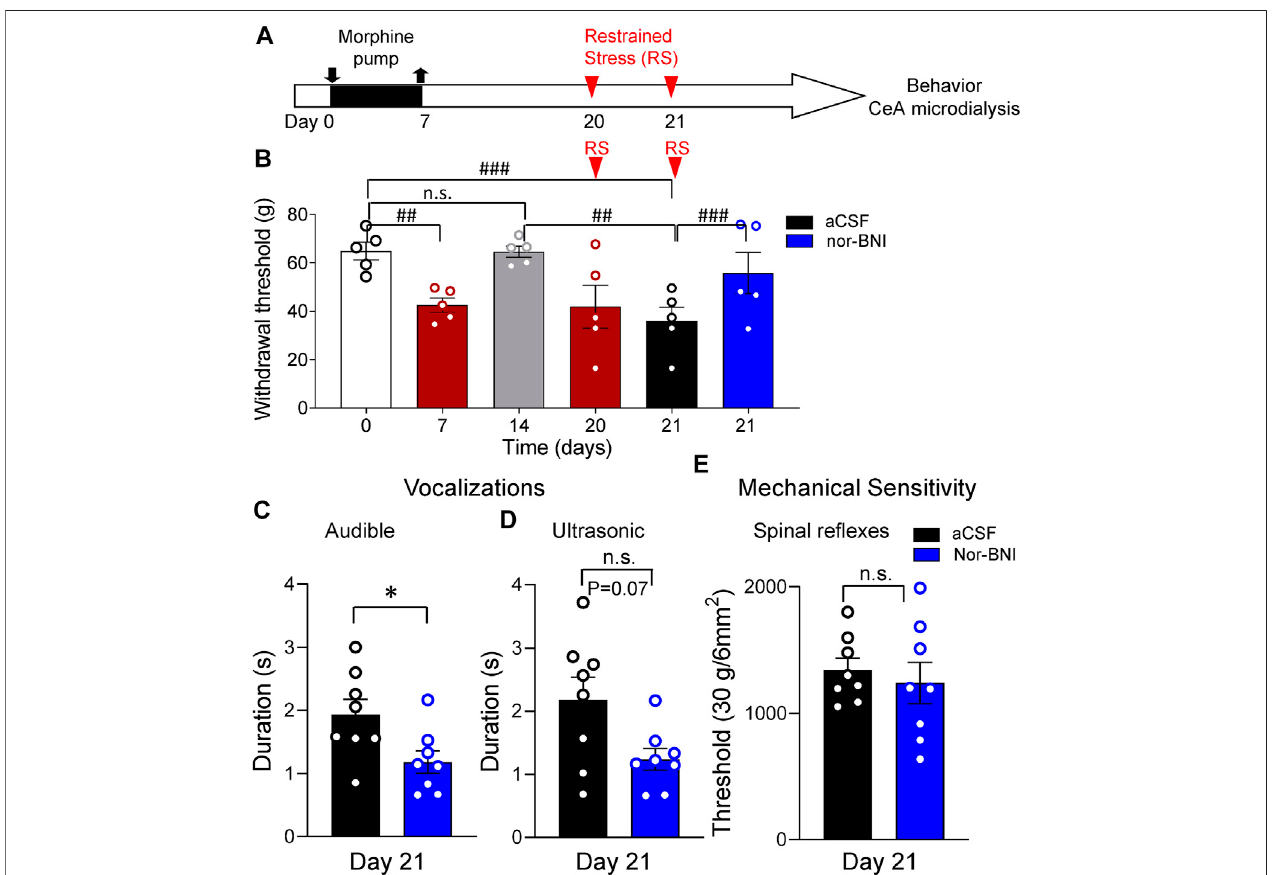
FIGURE 3 | Inhibitory effects of intra-CeA KOR antagonist (nor-BNI) on pain-like and affective behaviors in a functional pain model. (A) Timeline of experimental procedures. Rats were treated with morphine for 7 days. Restrained stress (RS) was induced on days 20 and 21. (B) Morphine priming decreased paw withdrawal thresholdsmeasured withelectronicvonFrey onday 7( ## p < 0.01, ANOVA RM, Tukey ’ sposthoc test, n =5). Byday 14mechanosensitivityrecoveredtobaseline levels (n.s., p > 0.05,ANOVARM,withTukey ’ sposthoctest, n =5).RSonday21pawsigni fi cantlydecreasedwithdrawalthresholdscomparedtoday0andday14( # p < 0.05, ANOVA RM, with Tukey ’ s posthoc test, n = 5). Nor-BNI (100 μ M in microdialysis probe) administered into the CeA signi fi cantly increased withdrawal thresholds compared to vehicle (aCSF) ( p < 0.001, ANOVA RM, Tukey ’ s posthoc test, n = 5). (C,D) After RS on day 21, nor-BNI signi fi cantly increased audible vocalizations (C)